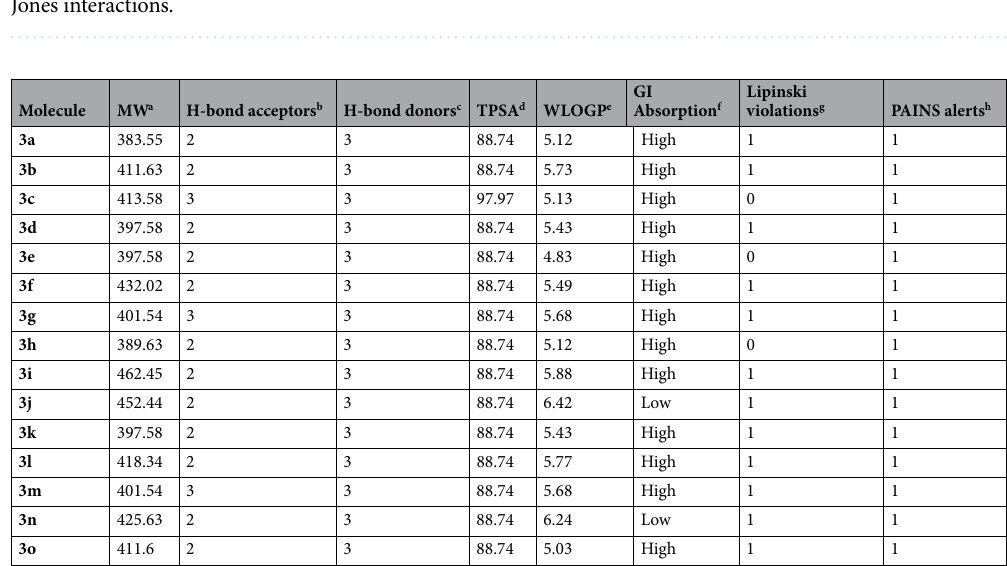
Figure 6. Root-mean-square deviation (RMSD) and short-range interaction energy profiles for 3m in the ALR2 active site. ( a ) RMSD of protein backbone, cofactor and 3m . ( b ) Short-range coulombic and Lennard- Jones interactions.